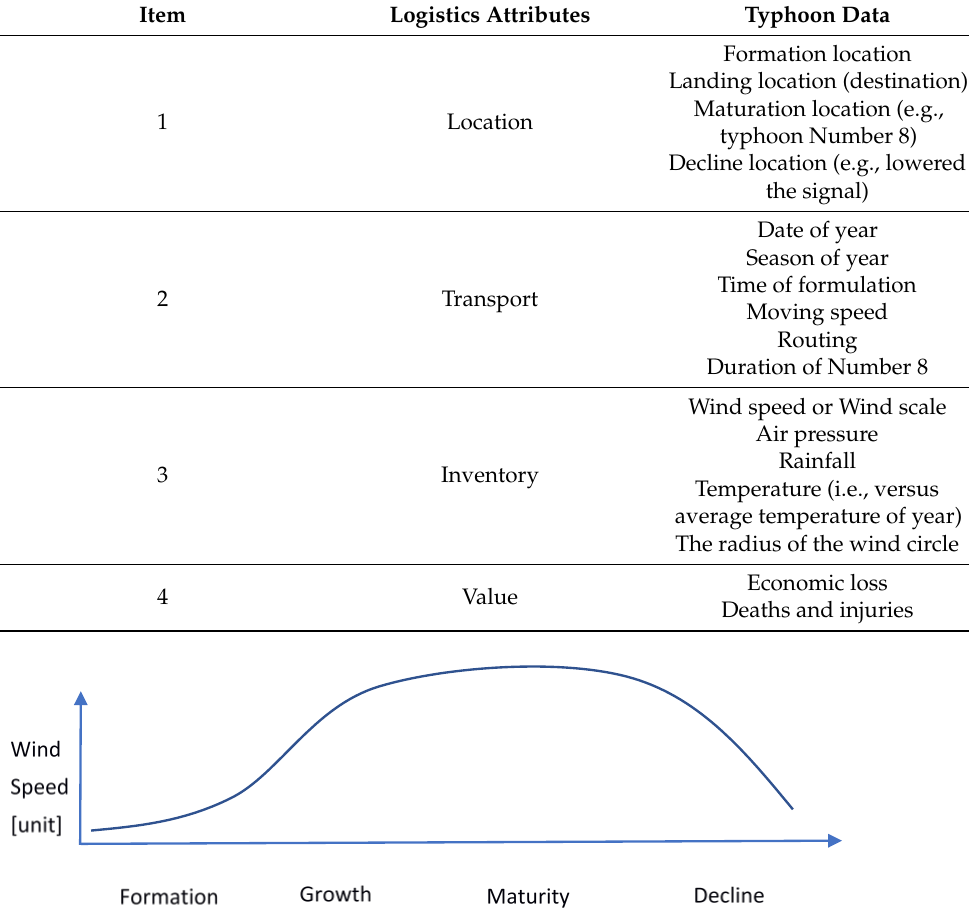
Figure 1. Product life cycle (PLC) of a typhoon event.